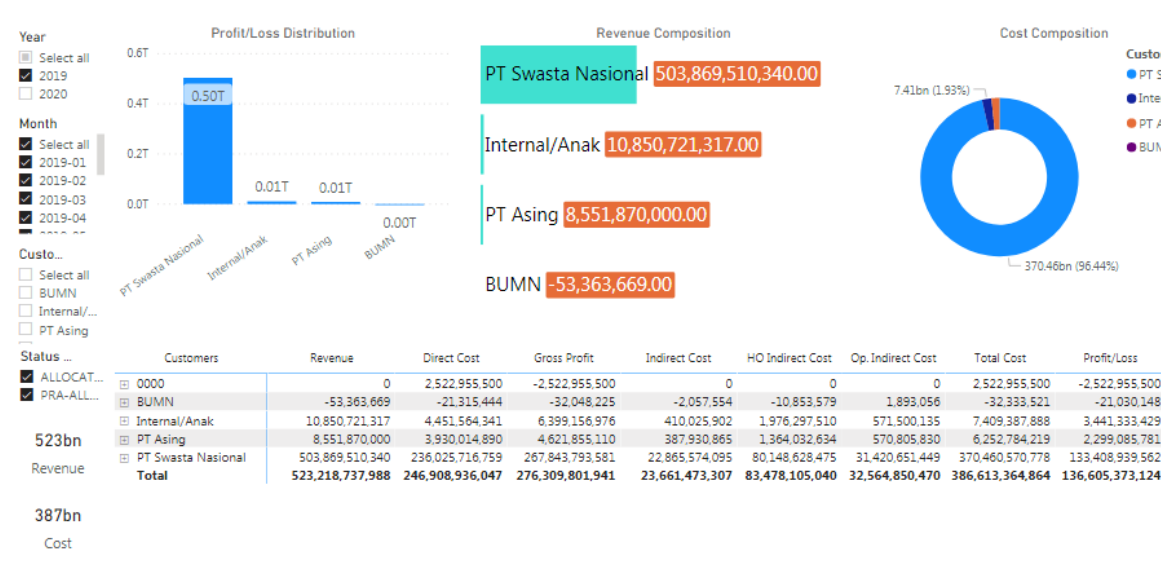
Figure 13: Cost Accounting Dashboard based on